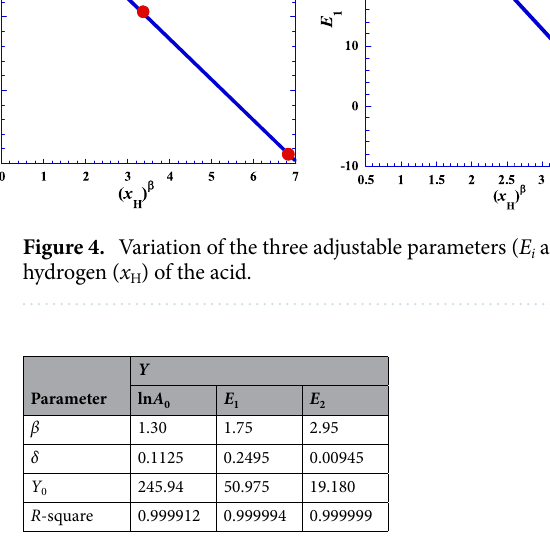
Table 4. Optimal Arrhenius parameters ( Y 0 , δ and β ) from non-linear regression of Eq. (12).